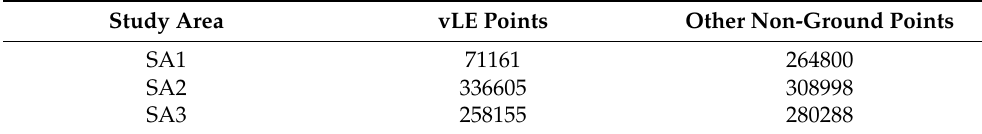
Table 3. Number of non-ground LiDAR points by